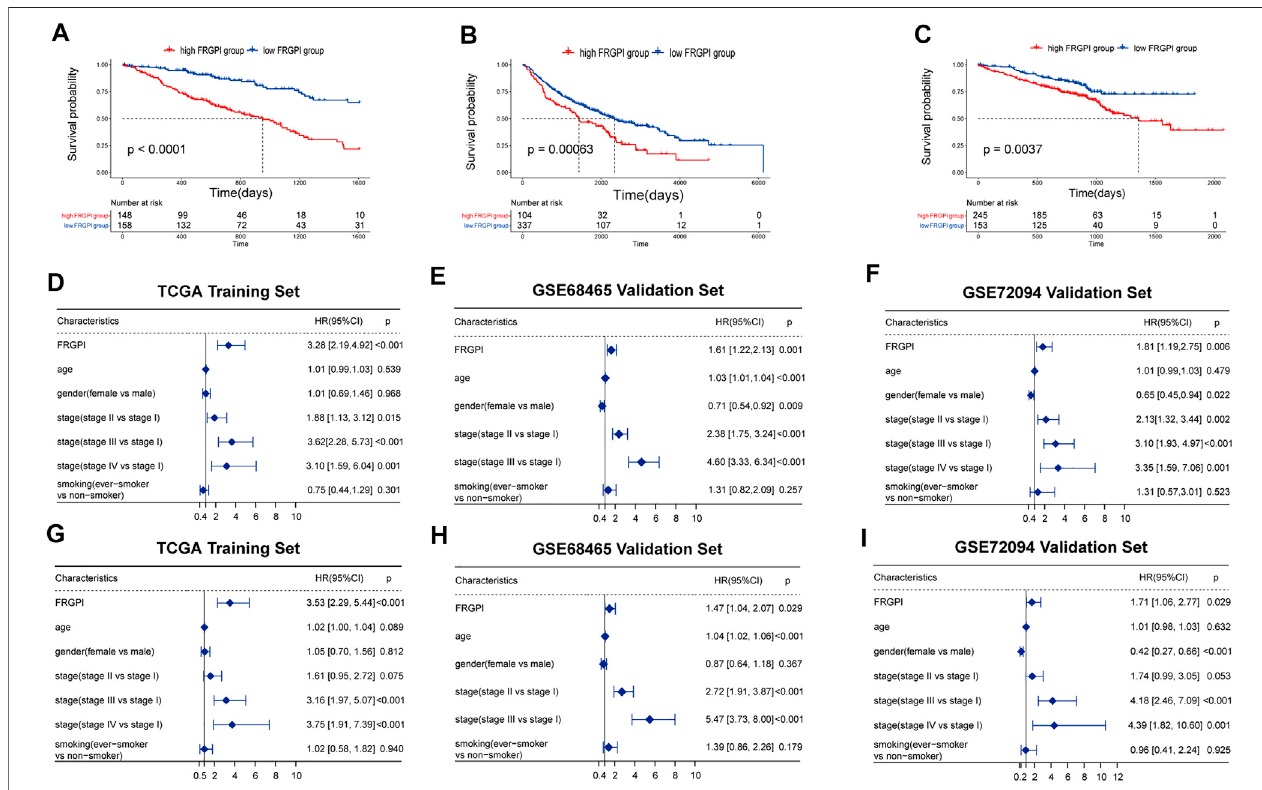
FIGURE 3 | Veri fi cation of FRGPI as an independent prognostic biomarker. (A – C) Kaplan – Meier curves between high- and low-risk FRGPI groups in training and validation sets. (D – F) Univariate Cox analyses of the three cohorts. (G – I) Multivariate Cox analyses of the three cohorts.